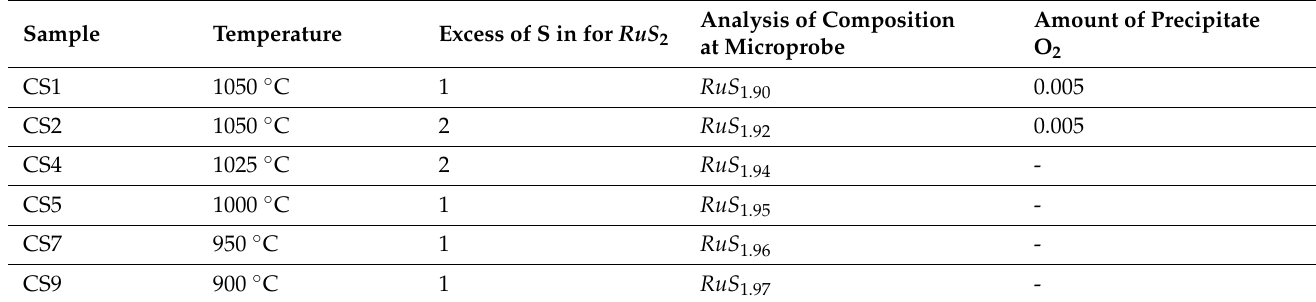
Table 2. Analysis of crystals formed by CVT technique .